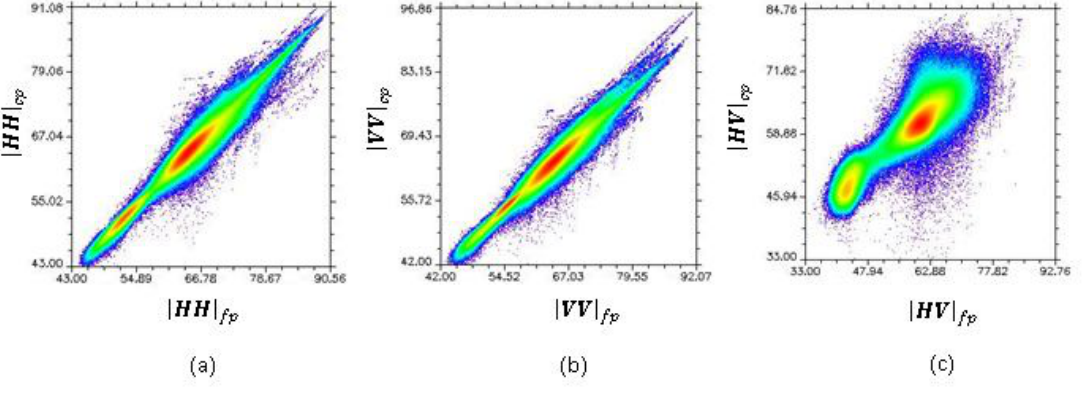
Figure 5 : Reconstruction performance for H, V and X channels. Scatter plots of (a) H fp - H CP , (b) V fp - V cp and (c) X fp - X